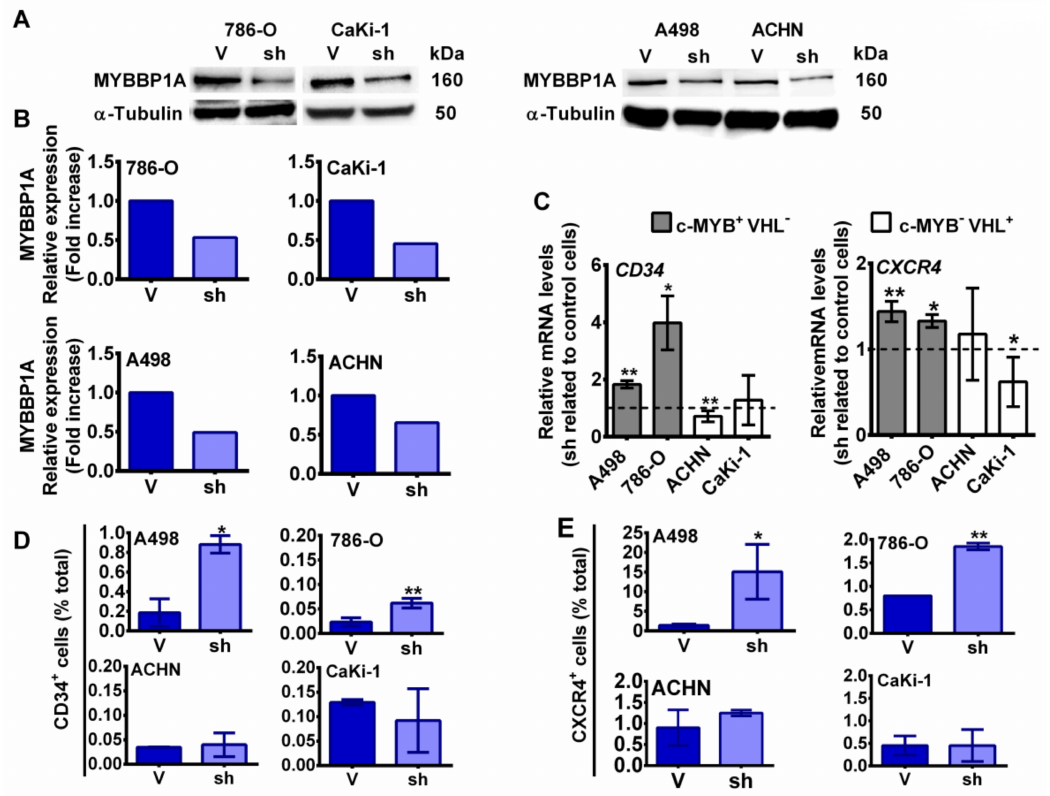
Figure 2. MYBBP1A knock down increases c-MYB activity. ( A ) MYBBP1A knock down by the expression of a specific shRNA. Cell lines were transfected with MYBBP1A shRNA (sh) or